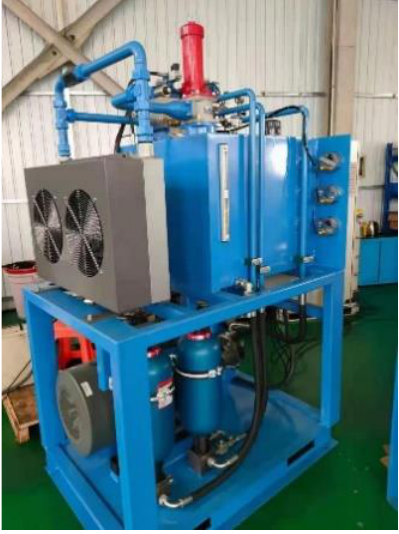
Figure 11. Photos of the hydraulic pump station of the loading system.